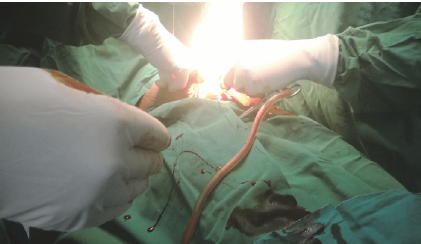
Figure 3: Haematometra blood debris amount measured approxi- mately 10